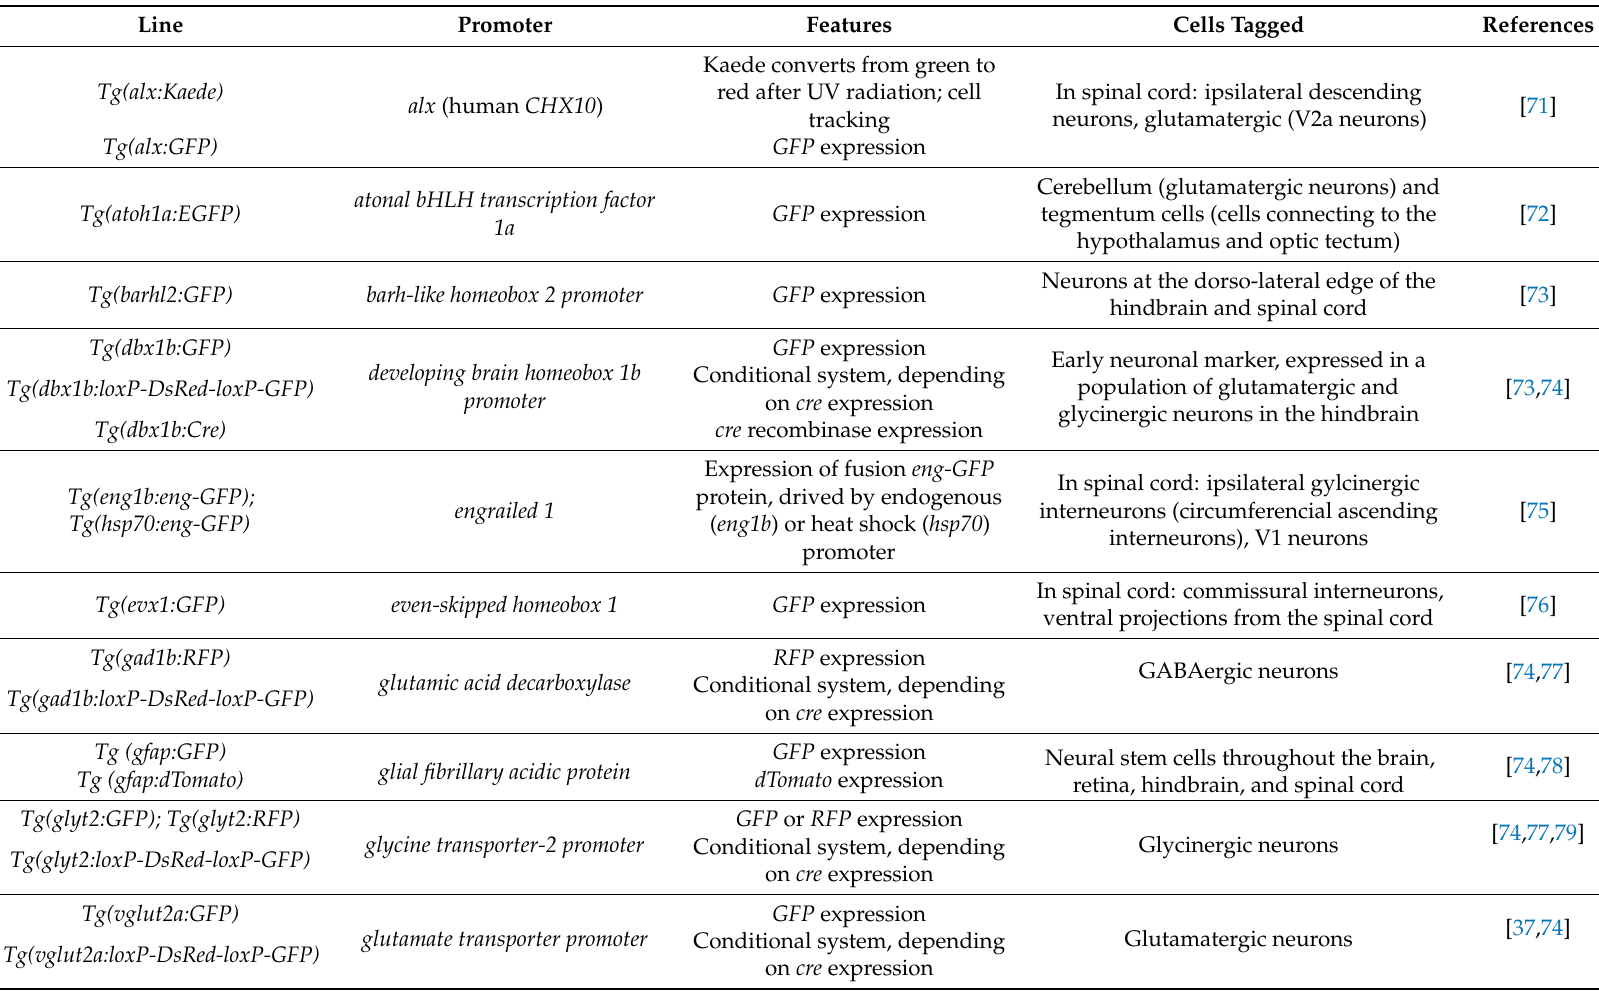
Table 1. Zebrafish transgenic lines used in neurodevelopment research. Common transgenic lines used to study neurogenesis, specifying the type of genetic construct used to generate the transgenic lines and the cells